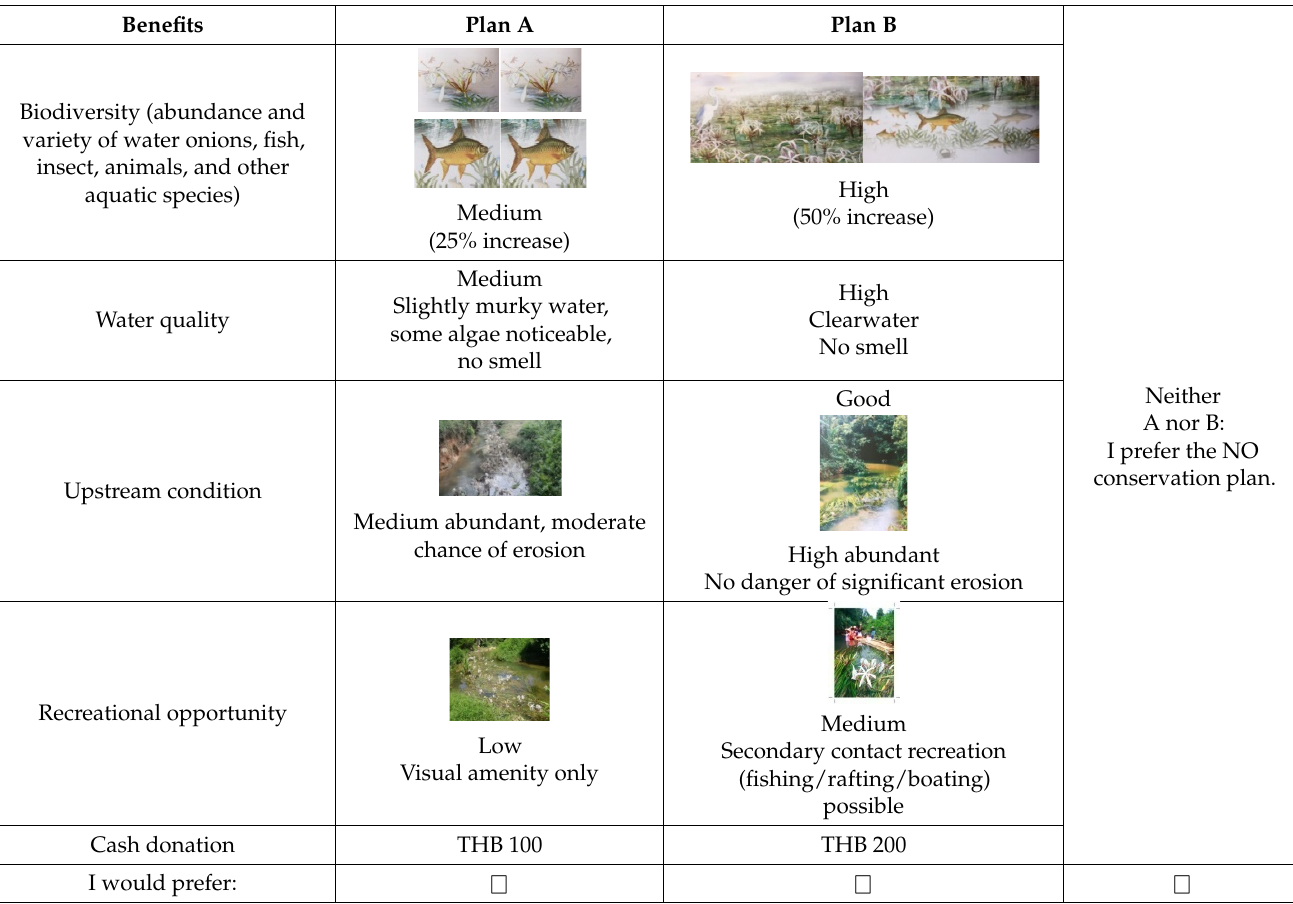
Table 2. Example of a choice set for the CE task in monetary terms.